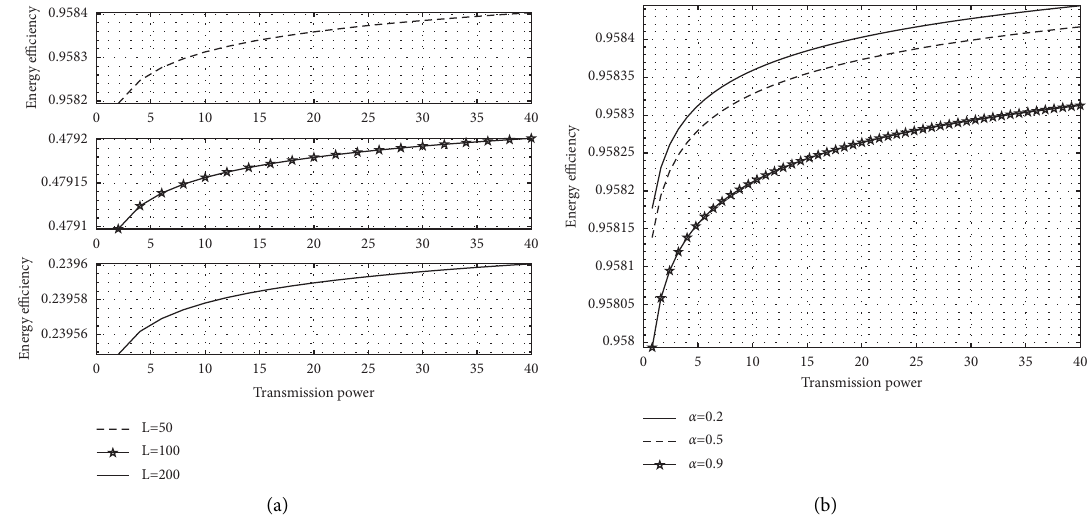
Figure 8: Energy efficiency against transmission